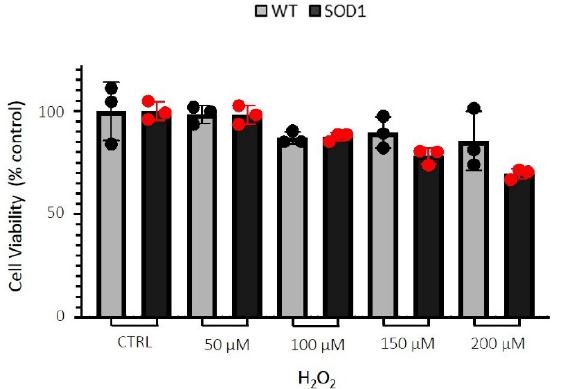
Figure 1. Effects of H 2 O 2 on the viability of SH-SY5Y WT and SOD1 G93A cells. The SH-SY5Y WT and SOD1 G93A cells were plated at a density of 40,000 cells/well in 96-well plates. Once confluence was reached, they were treated with increasing concentrations of H 2 O 2 (50–200 µ M) for 24 h. At the end of the treatment, cell viability was assessed by MTT assay. The results are expressed as mean ± SEM of data obtained from 3 independent experiments. In each experiment, groups consisted of 7 replicates for each treatment (total n = 21).